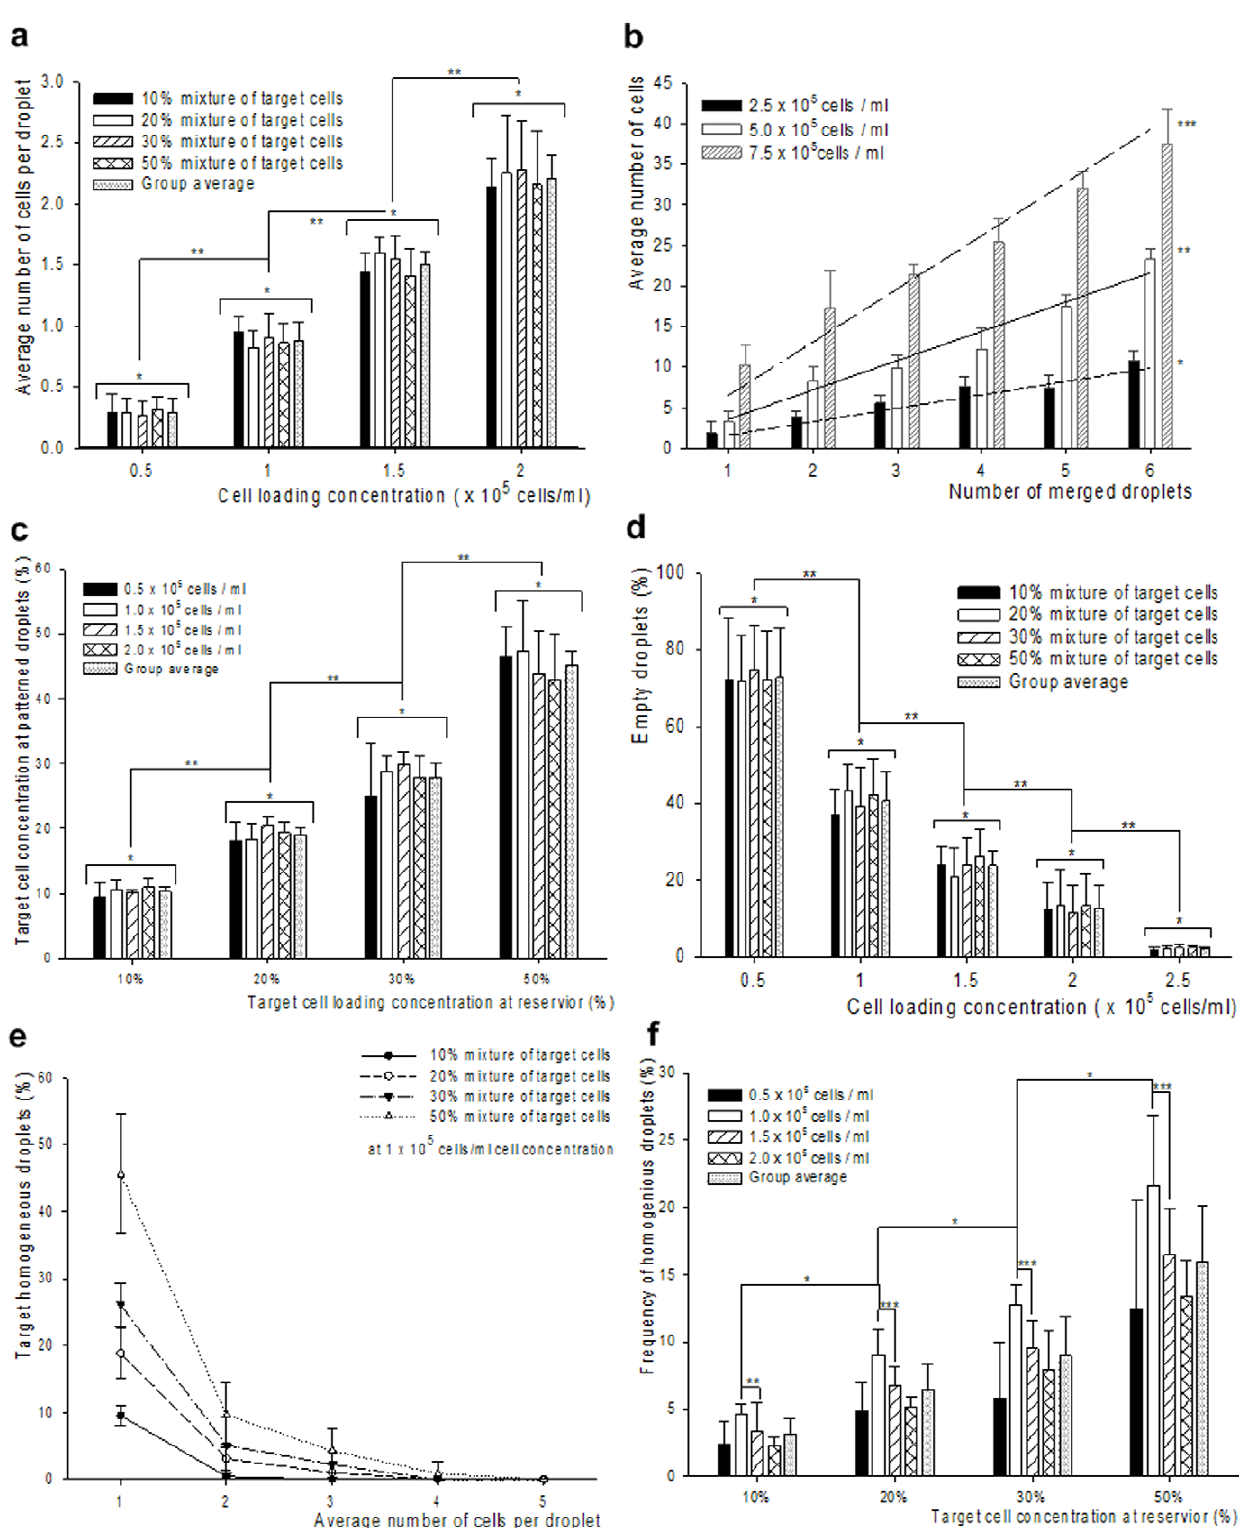
Figure 3. Homogeneous droplet analyses. ( a ) Droplets are generated at cell concentrations: 0.5 6 10 5 , 1.0 6 10 5 , 1.5 6 10 5 , and 2.0 6 10 5 cells/ml and they contained 0.28 6 0.12, 0.88 6 0.14, 1.50 6 0.10, and 2.20 6 0.19 cells per droplet, respectively (mean 6 standard deviation). The droplets were ejected using two controlled parameters: 34 kPa nitrogen gas pressure and 55 m s valve opening period. Values were obtained from 5 groups, each containing 100 droplets. Each group was tested by single factor analysis of variance (ANOVA). F(3,16)=0.15, 0.58, 1.22, and 0.16, n=5 mean values per each group, *p . 0.33. (Student’s t-test between target cell concentrations: **p , 0.0004, n=5 mean values of 4 concentrations). ( b ) Number of cells in droplets was obtained at cell concentrations: 2.5 6 10 5 , 5.0 6 10 5 , and 7.5 6 10 5 cells/ml. Regression coefficients, R 2 values, were *0.93 (1.7 cells/